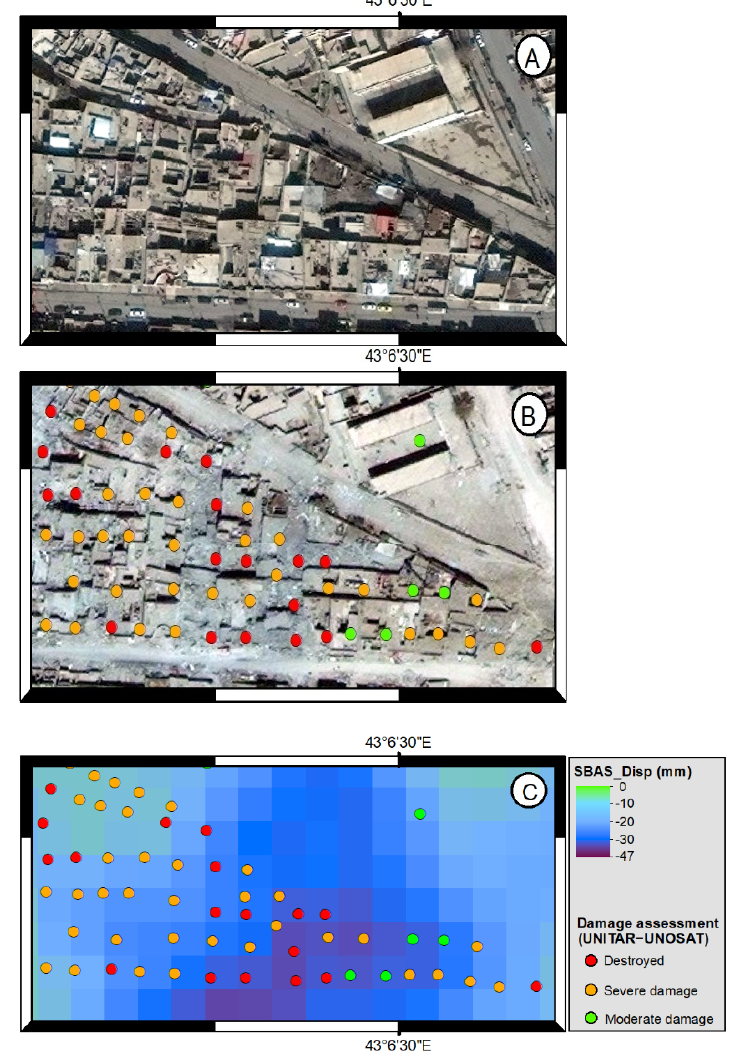
Figure 5. Cross comparison of the UNITAR result with the SBAS displacement map. ( A ) WorldView- 3 Imagery (18 February 2017) and ( B ) GeoEye-1 Imagery (4 August 2017) of the Al-Shafaa district (Copyright: DigitalGlobe, Inc. and Source: Department of State, Humanitarian Information Unit, NextView License). ( C ) SBAS displacement map with three classes of damaged severity shown in colored dots, courtesy of UNITAR-UNOSAT. The source for the UNITAR-UNOSAT map is available at: http://unosat-maps.web.cern.ch/unosat-maps/IQ/CE20140613IRQ/UNOSAT_A3_Mosul_dam-